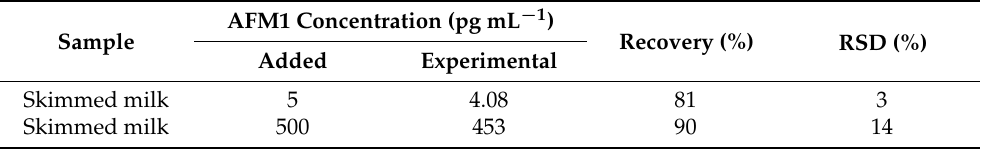
Table 2. Recoveries for AFM1 spiked milk samples ( n =